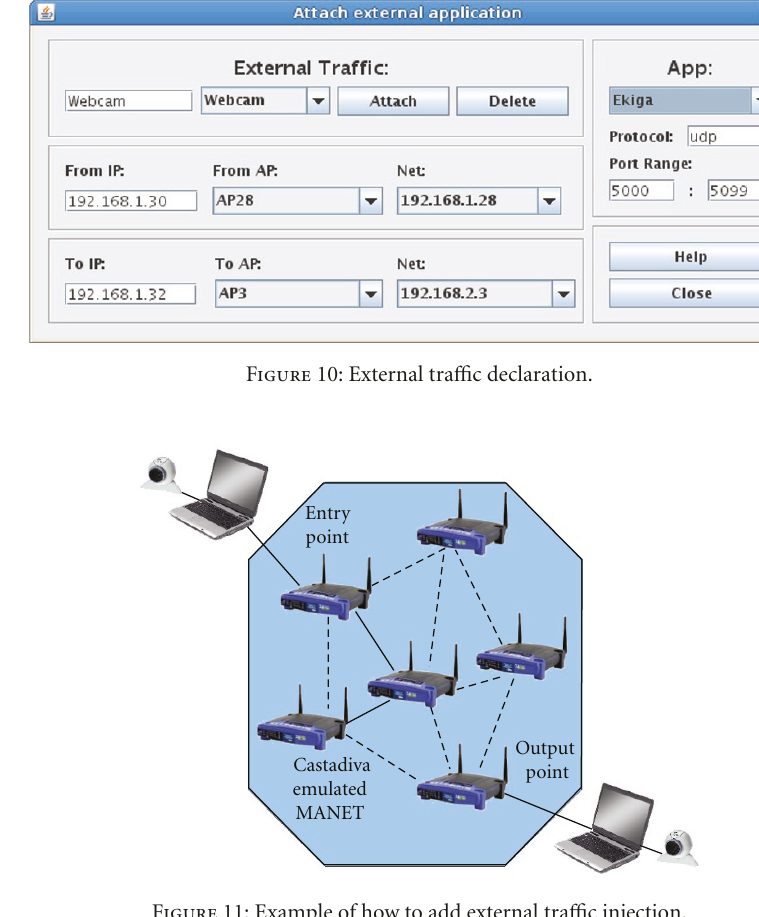
Figure 11: Example of how to add external tra ffi c injection.